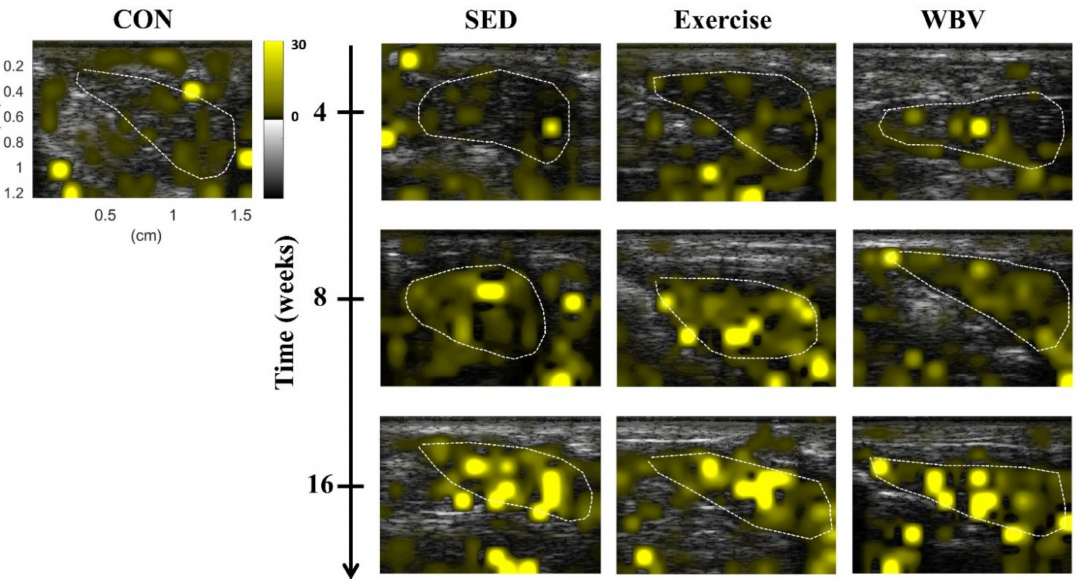
Figure 2. Ultrasound HK µ parametric images of mouse liver in various groups and intervention periods. CON: control; SED: sedentary; WBV: whole-body vibration. The delineated contours described by white dotted lines represent the ROIs for the data analysis.